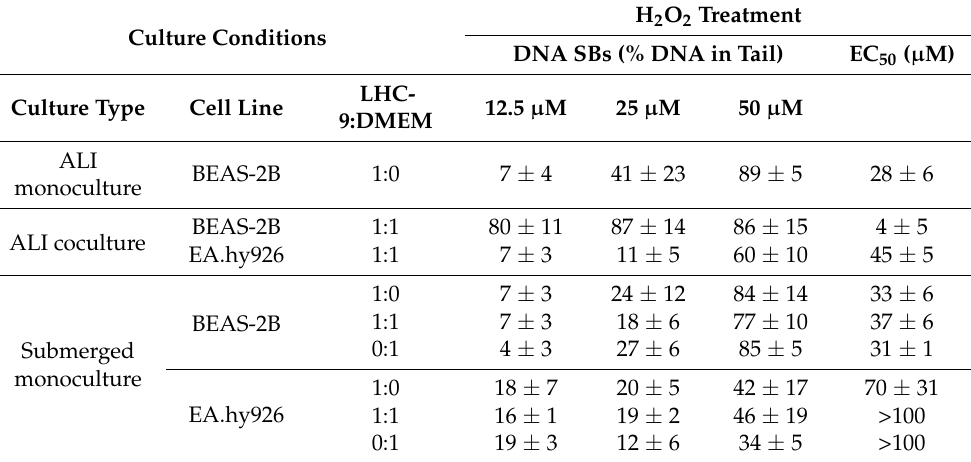
only ( p = 0.04), and the increase in micronuclei formation was not statistically significant from the PBS control ( p = 0.08). The proportion of binucleated cells in the samples